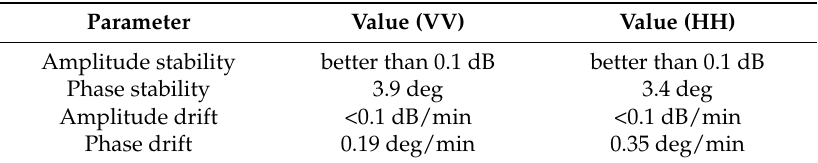
Table 5. Amplitude and phase stability results over 10 min.